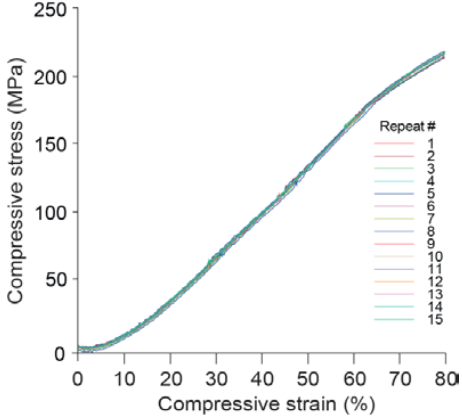
Figure 3. Compressive stress vs strain profile for Seb-PEH 2 over 15 compression cycles.